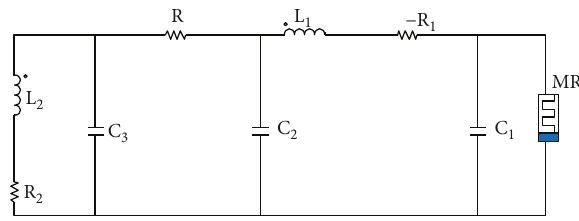
Figure 1: The memristor-based chaotic